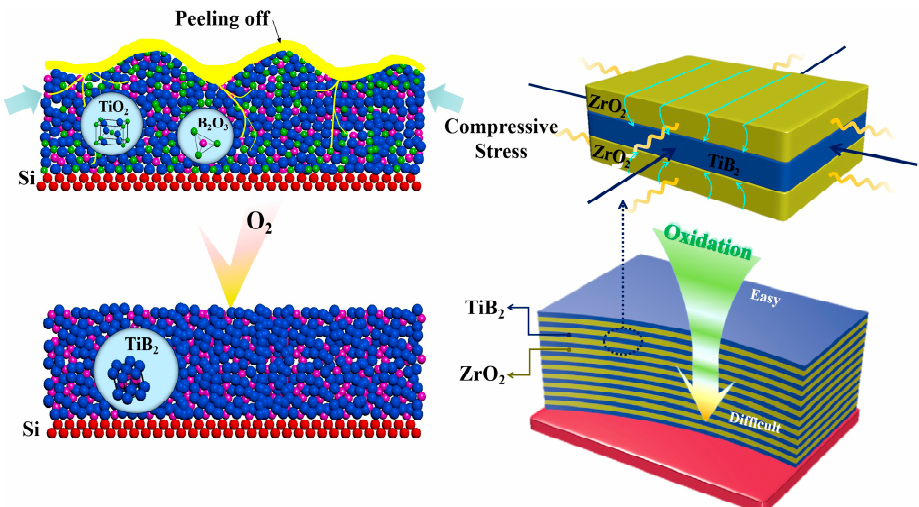
Figure 5. The oxidation mechanism of TiB 2 monolayer and TiB 2 /ZrO 2 multilayer.